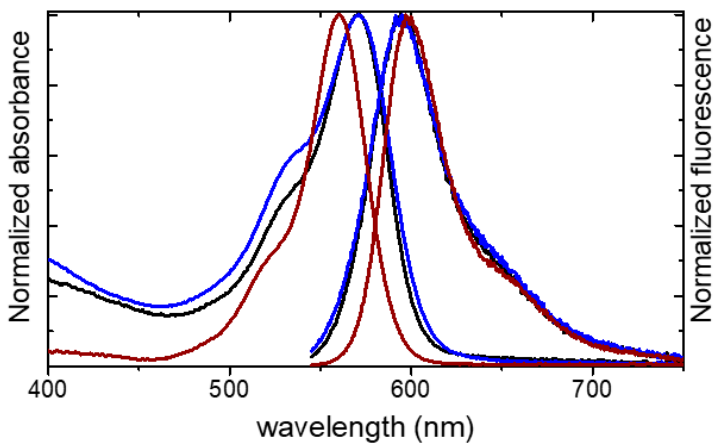
Figure 4. Normalized absorption and emission spectra for MSN-C-R101-70-PEG (black), MSN-S-R101-60-PEG (blue), and rhodamine 101 (brown) in diluted aqueous solution.